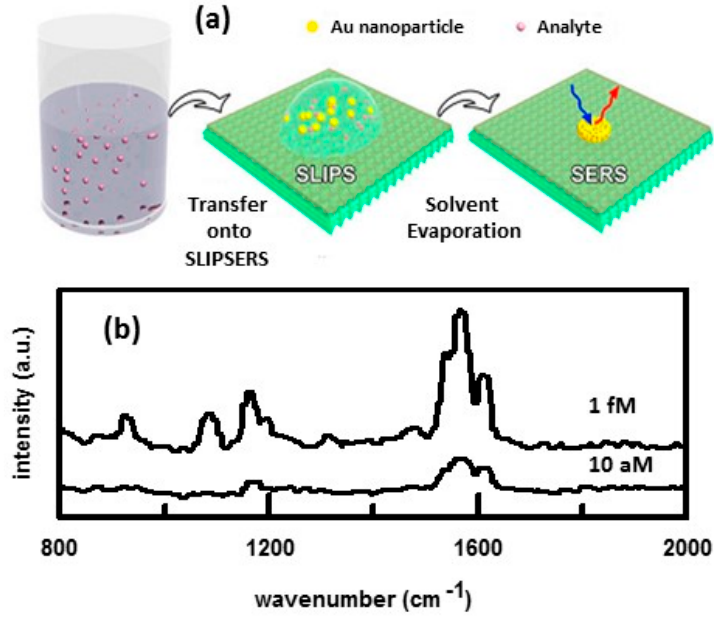
Figure 4. ( a ) Schematic illustration of liquid phase detection of an analyte using SLIPSERS. Au NPs are mixed with analyte to create a suspension. An aliquot of the suspension is placed onto the surface of the SLIPS. As the solvent evaporates, the particles cluster together to form a 3D aggregate consisting of closely packed Au NPs and adsorbed analyte molecules. ( b ) SERS spectra obtained for DEHP in ethanol. An initial volume of 50 µ L of analyte solution was used. Concentrations of DEHP are indicated. Spectra were obtained using 633 nm laser excitation. Reproduced with permission from Proceedings of the National Academy of Sciences, 2016 [67].